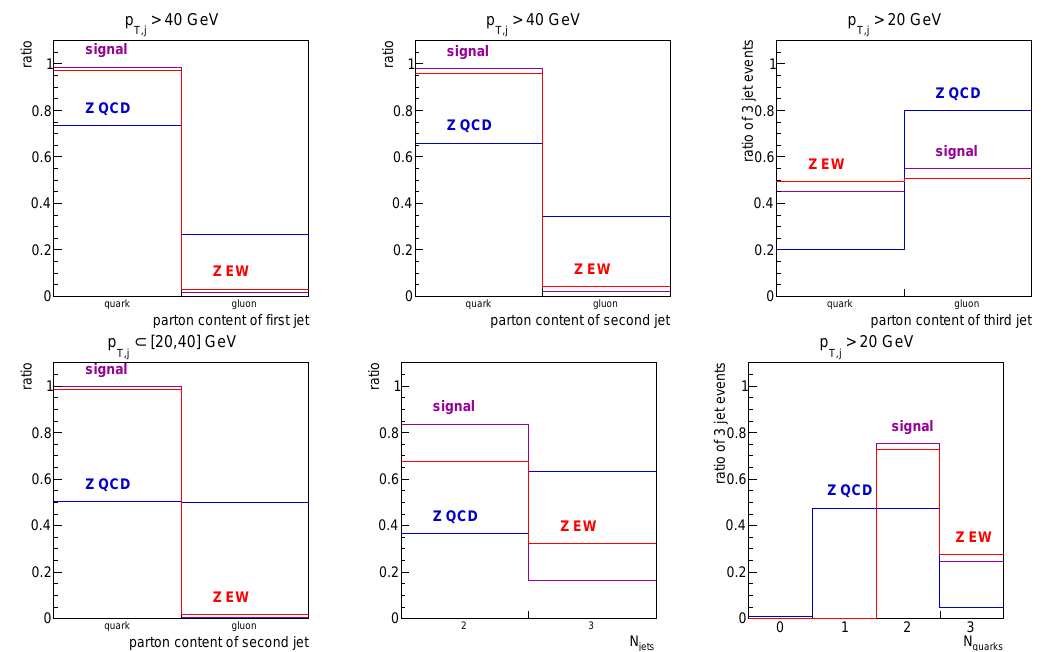
Figure 6: Parton content of the first, second, and third jet for WBF signal and the backgrounds, after the pre-selection cuts of Eq. (3). In addition, we show the parton = 20 ... 40 GeV, the number of jets, and the content of the second jet in the slice p T , j 2 number of quarks in three-jet events.